Question: Summarize what this figure shows in one sentence.
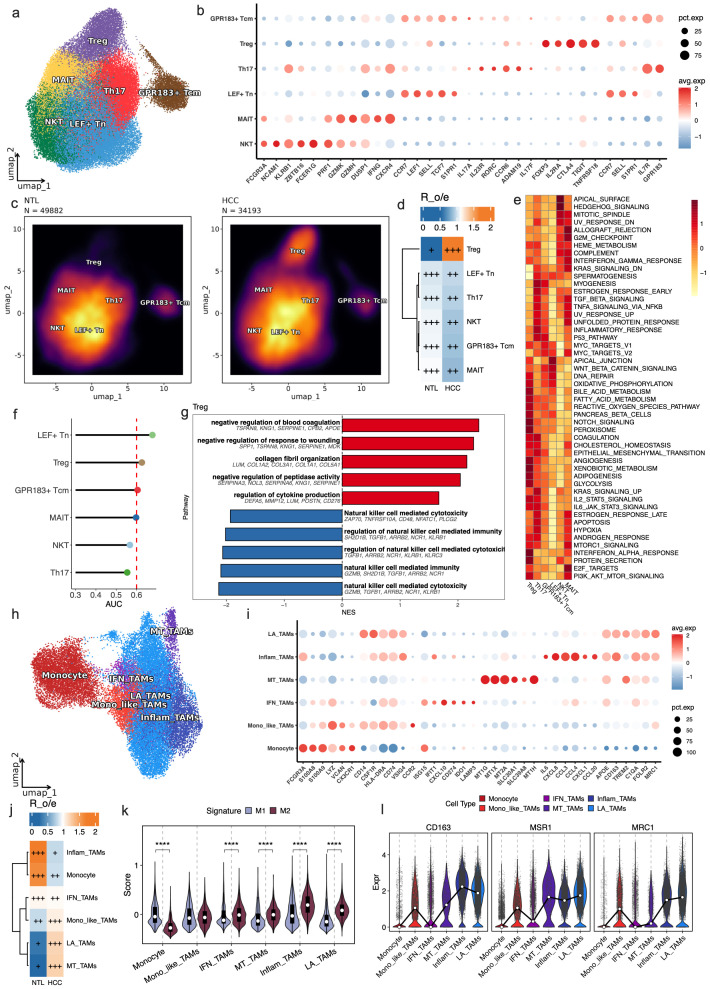
Answer: Single-cell transcriptomic analysis reveals the heterogeneity of lymphoid and myeloid cells in HCC. (A) UMAP dimensionality reduction showing the integrated cell distribution map. Six distinct T cell subsets were identified, each represented by a distinct color. (B) Dot plot showing the marker genes of six T cell subsets. (C) Grouped density plot showing the intergroup distribution of T cell subsets. (D) Tissue preference of each cluster estimated by the STARTRAC-dist index: +++, Ro/e > 1; ++, 0.8 < Ro/e ≤ 1; +, 0.2 < Ro/e ≤ 0.8; +/-, 0 < Ro/e ≤ 0.2; -, Ro/e = 0. (E) Heatmap of HALLMARK pathway enrichment in T cell subsets. (F) Augur analysis framework assessing the degree of transcriptomic perturbation in T cell subsets between biological states. (G) Bar plot of GSEA enrichment analysis for the Treg subset. (H) UMAP dimensionality reduction showing the integrated cell distribution map. Six distinct myeloid cell subsets were identified, each represented by a distinct color. (I) Dot plot showing the marker genes of six myeloid cell subsets. (J) Tissue preference of each cluster estimated by the STARTRAC-dist index: +++, Ro/e > 1; ++, 0.8 < Ro/e ≤ 1; +, 0.2 < Ro/e ≤ 0.8; +/-, 0 < Ro/e ≤ 0.2; -, Ro/e = 0. (K) Violin plot of M1/M2 scores across six myeloid cell subsets. (L) Violin plot of differentially expressed genes in myeloid cell subsets.****, P<0.0001.